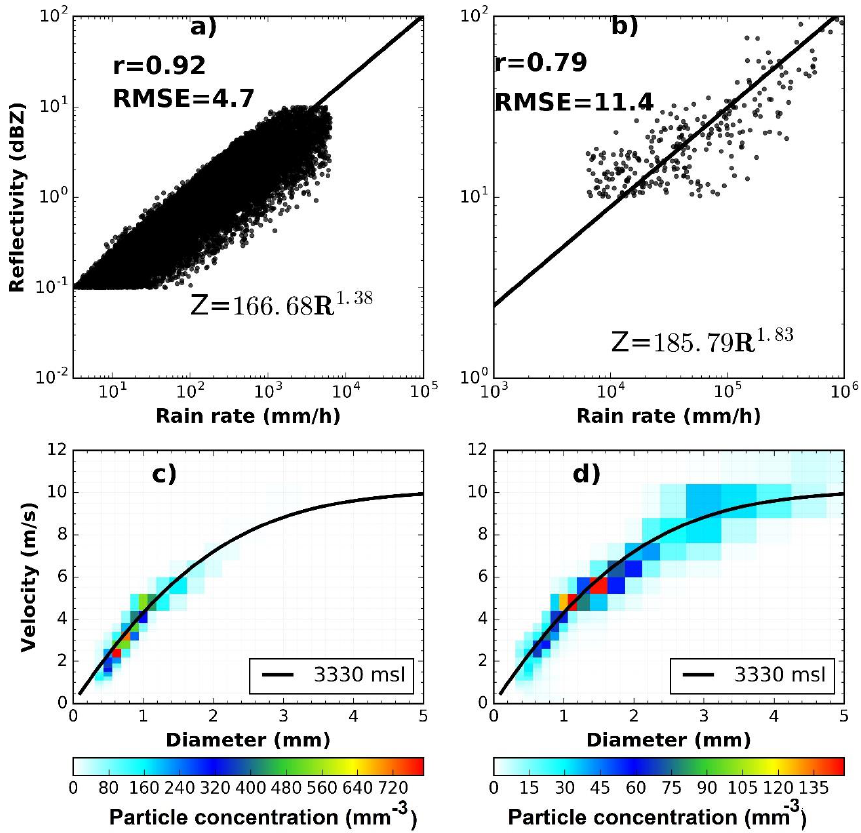
Figure 9. Correlations between reflectivity and rain rate and velocity and diameter of the rainfall that occurrence in the valley. ( a ) and ( c ) stratiform rainfall, ( b ) and ( d ) convective rainfall.